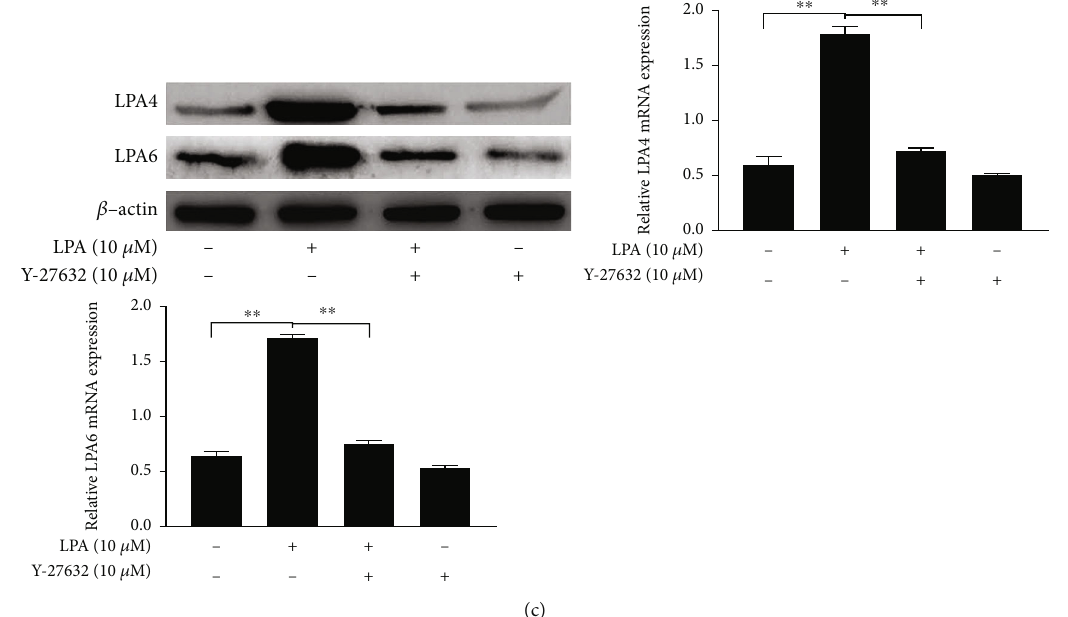
Figure 5: LPA and Rho kinase inhibitors a ff ect the expression of LPA4 and LPA6 in spinal cord neurons. (a, b) The expression of LPA1, LPA2, LPA3, LPA4, LPA5, and LPA6 mRNAs in spinal cord neurons were measured by RT-qPCR. (c) The expression of LPA4 and LPA6 in spinal cord neurons were measured by western blotting. Asterisks indicate statistical signi fi cance ( ∗ p < 0 : 05 , ∗∗ p < 0 : 01